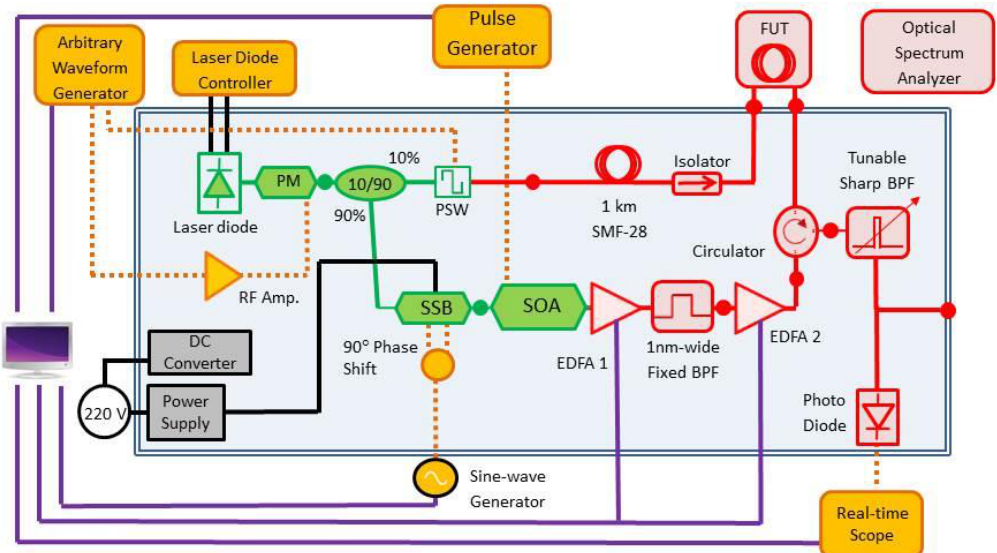
Figure 1. Schematic illustration of the measurement setup used in phase-coded Brillouin optical correlation domain analysis along fibers under test that were embedded in composite structures. Red, solid lines: standard single-mode fiber paths. Green, solid lines: polarization-maintaining fiber paths. Magenta, solid lines: instrumentation control lines. Orange, dashed lines: electrical radio-frequency signals paths. Black, solid lines: DC power supply lines. (Several additional power supply connections are not shown, for better clarity.) FUT: fiber under test. SOA: semiconductor optical amplifier. SSB: single-sideband electro-optic modulator. RF Amp.: radio-frequency amplifier. BPF: optical bandpass filter. EDFA: erbium-doped fiber amplifier. PSW: polarization switch. PM: electro-optic phase modulator. Closed circles represent input/output fiber connections for test-points or equipment interface.